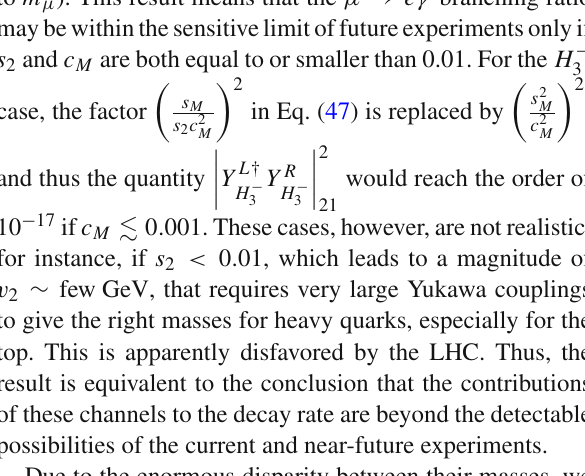
to m μ ). This result means that the μ → e γ branching